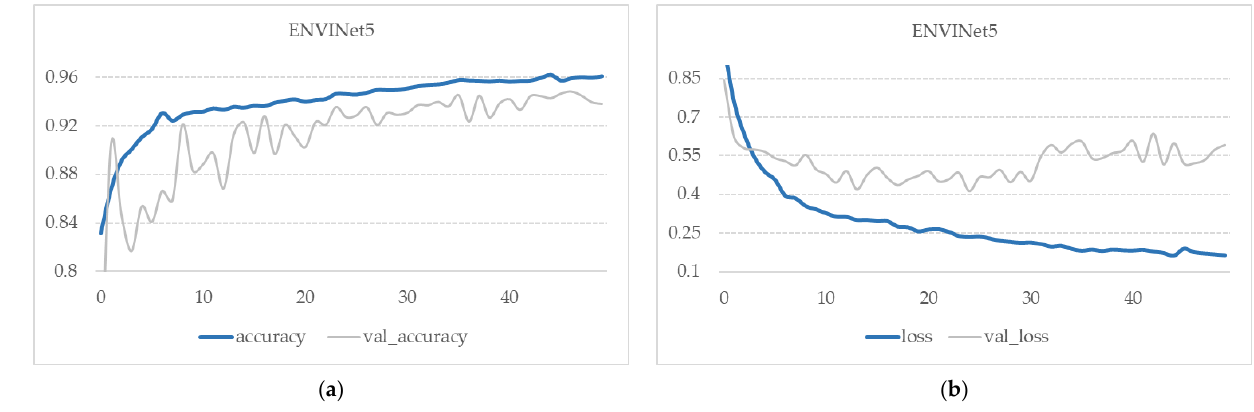
Figure 6. Model performance: ( a ) accuracy and ( b ) loss for our fine-tuned ENVINet5.